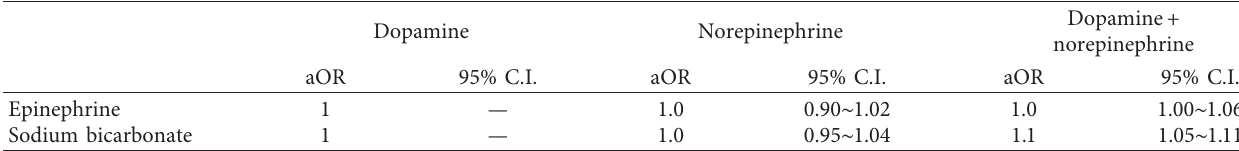
Table 3: Association between postresuscitation inotropic agent therapy and resuscitation medication.